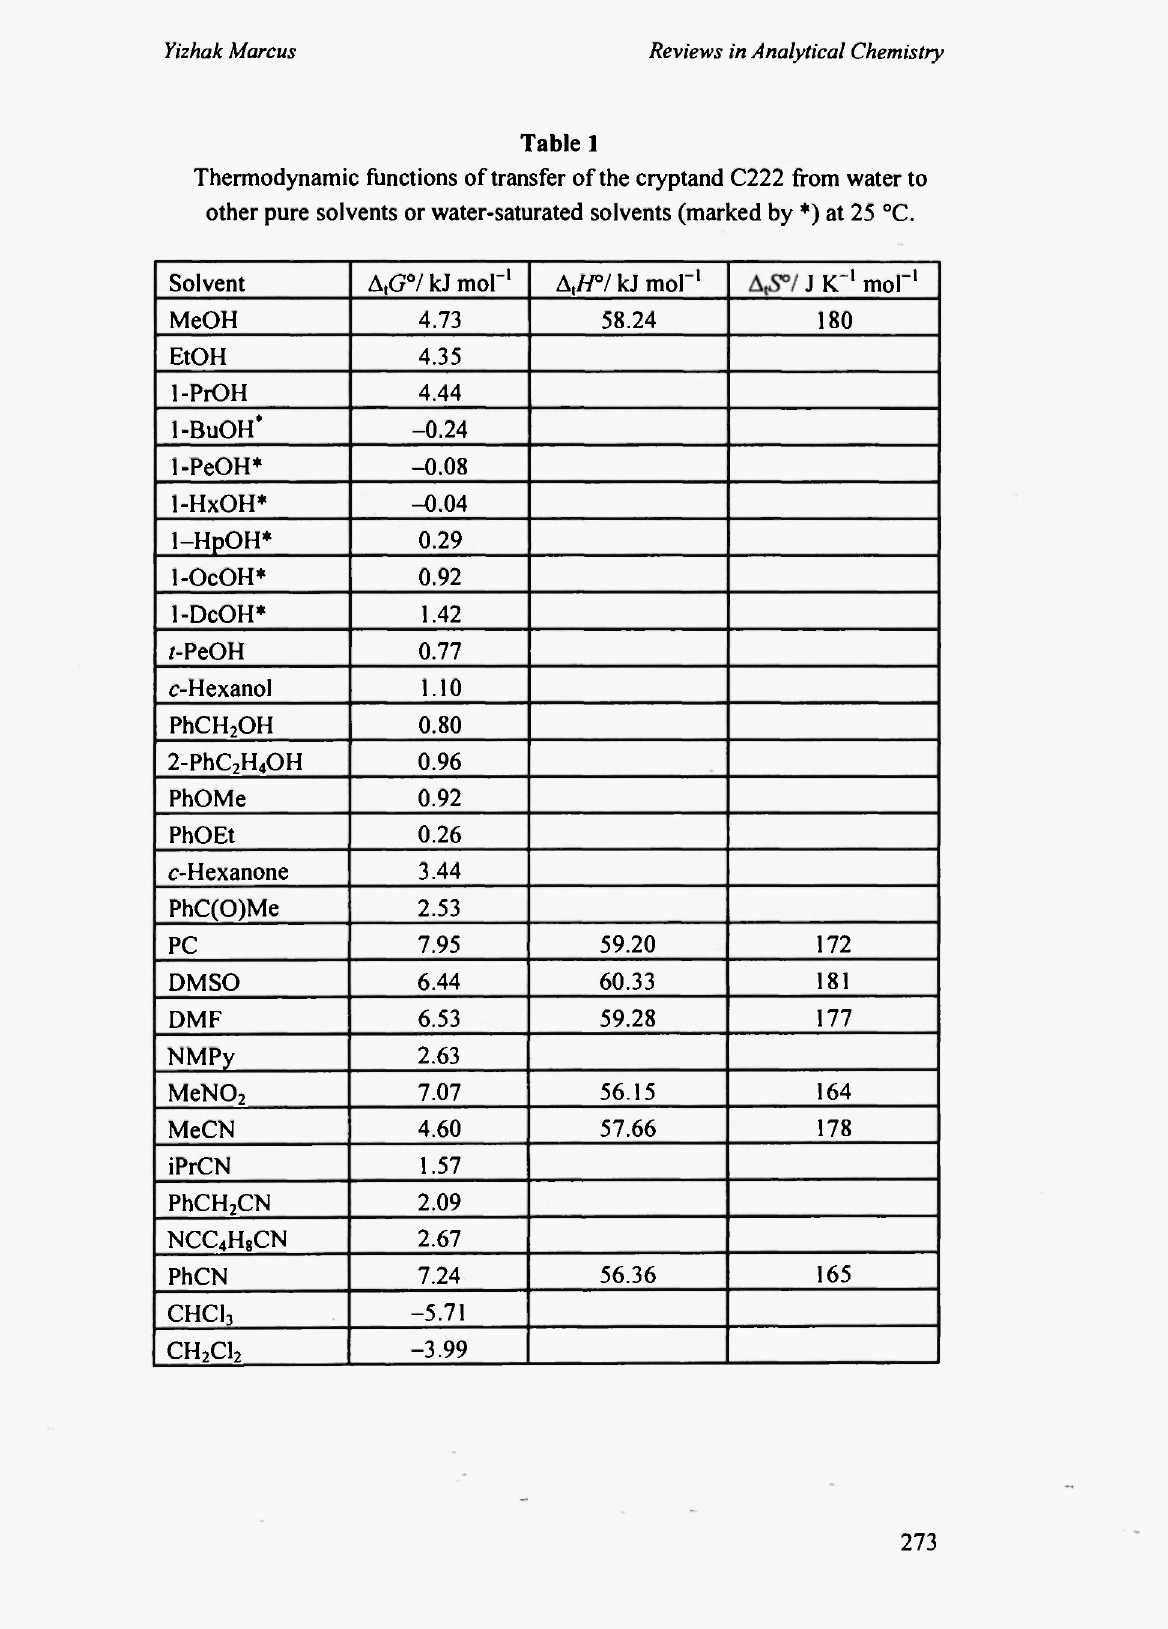
Thermodynamic functions of transfer of the cryptand C222 from water to other pure solvents or water-saturated solvents (marked by *) at 25